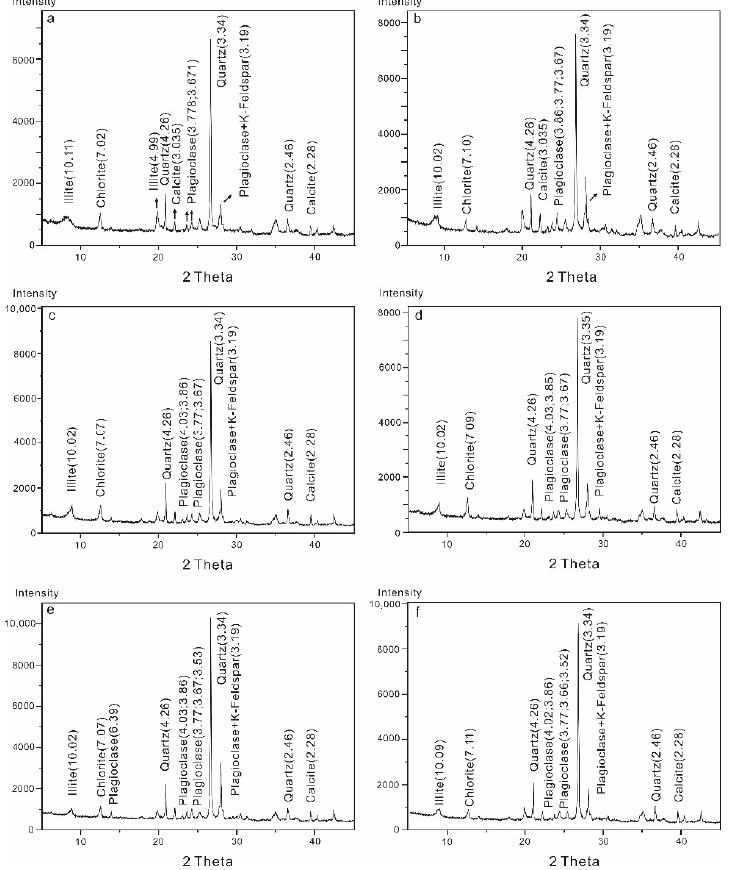
Figure 4. XRD patterns of six typical samples of whole ‐ rock minerals at different depths in the Shahezi mineral of the SK ‐ 2. ( a ) Mudstone sample at 3536 m; ( b ) mudstone sample at 3826 m; ( c ) mudstone sample at 4206 m; ( d ) mudstone sample at 4545 m; ( e ) mudstone sample at 5045 m; ( f ) mudstone sample at 5535 m. N: air-dried sample; EG: ethylene glycol saturated sample; T: heated sample. The clay mineral assemblages of the Shahezi Formation include illite (68%), chlorite (15%), and illite–smectite-ordered interlayer mineral (17%) (Figure 5, Table S1). Among them, the content of illite continues to increase with the increase of depth above 4500 m. The content of smectite in the ordered interlayer mineral and the interlayer mineral